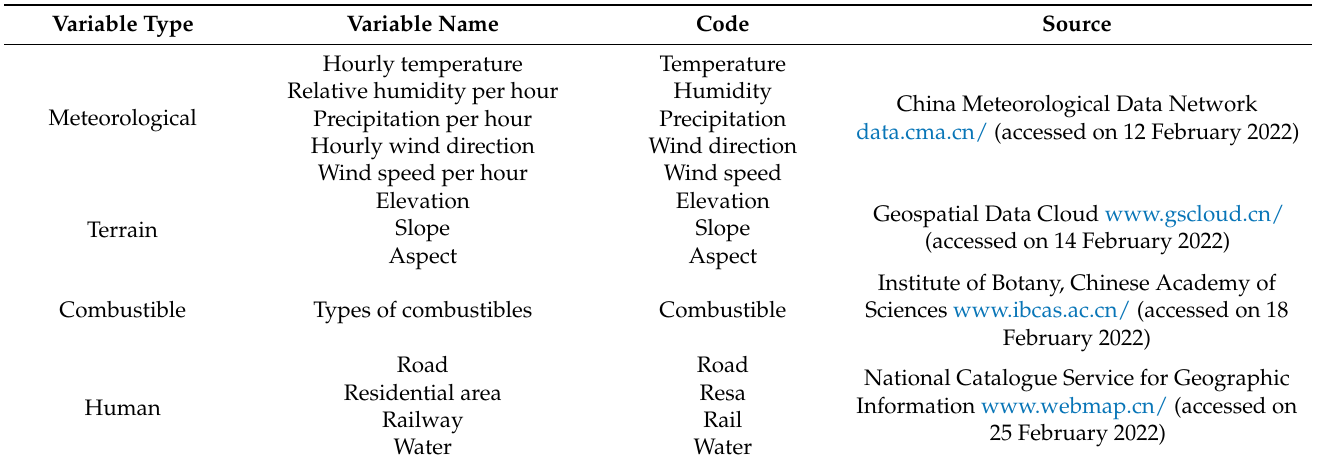
Table 2. Variables affecting forest fires.